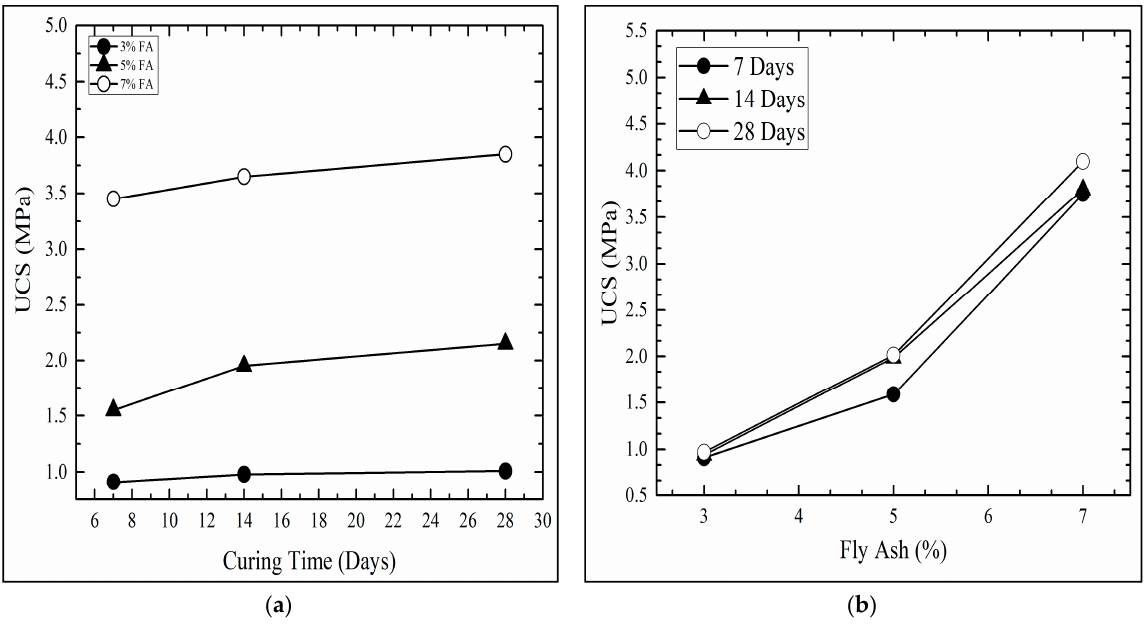
Figure 7. Effect of FA on the UCS and different curing time (7, 14, and 28 days) for the 50:50 treat mixtures.